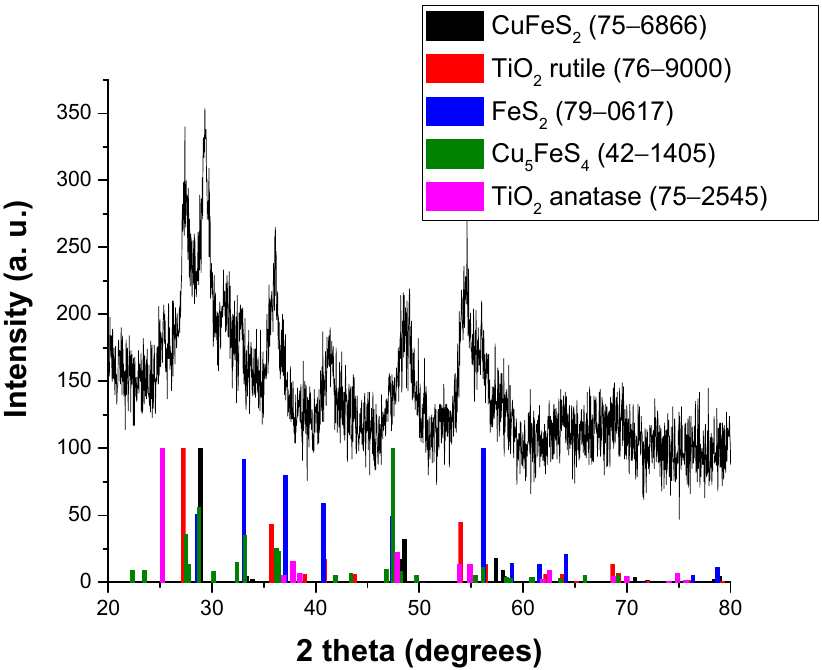
Figure 2. XRD pattern of CuFeS 2 /TiO 2 nanocomposite.